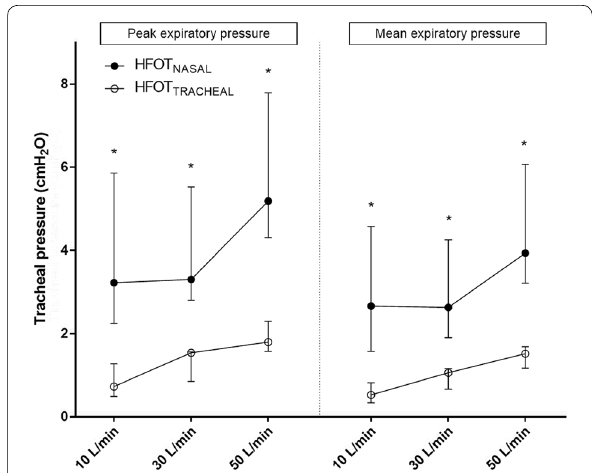
Fig. 4 Peak and mean expiratory pressure during HFOT TRACHEAL and HFOT NASAL and different gas flows delivered. Results are displayed as median and interquartile range; *indicates p vs. HFOT NASAL